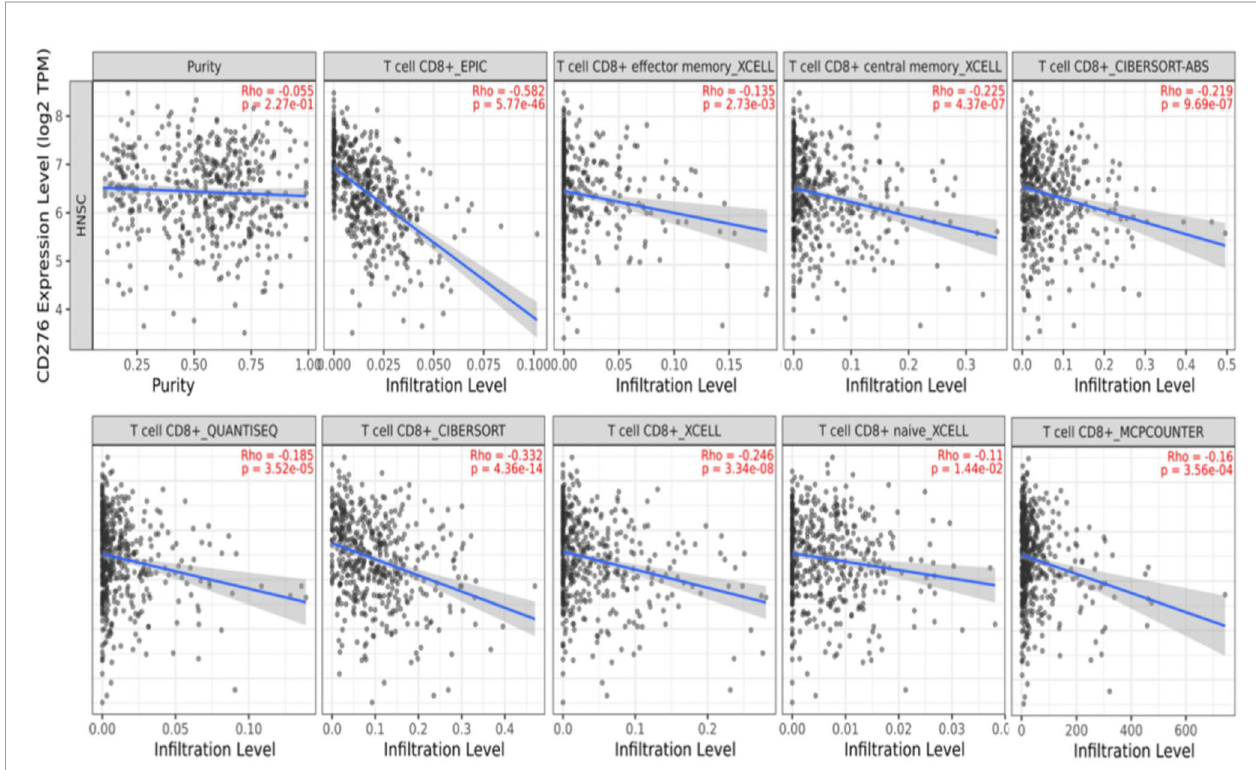
FIGURE 5 | Correlation of B7-H3 expression with in fi ltration of CD8 + T cells. The data was obtained from TCGA HNSCC datasets and analyzed by 6 different algorithms from TIMER